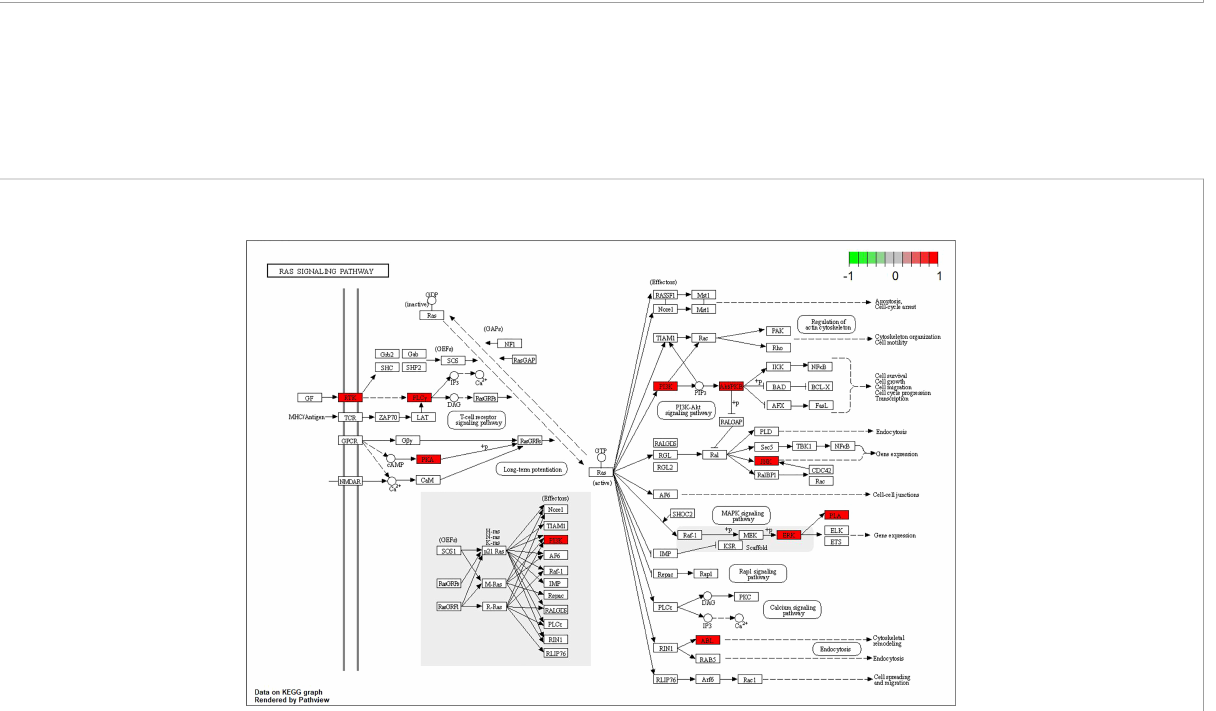
FIGURE 8 Ras signaling pathway map (nodes in red represent 4m-AD-related